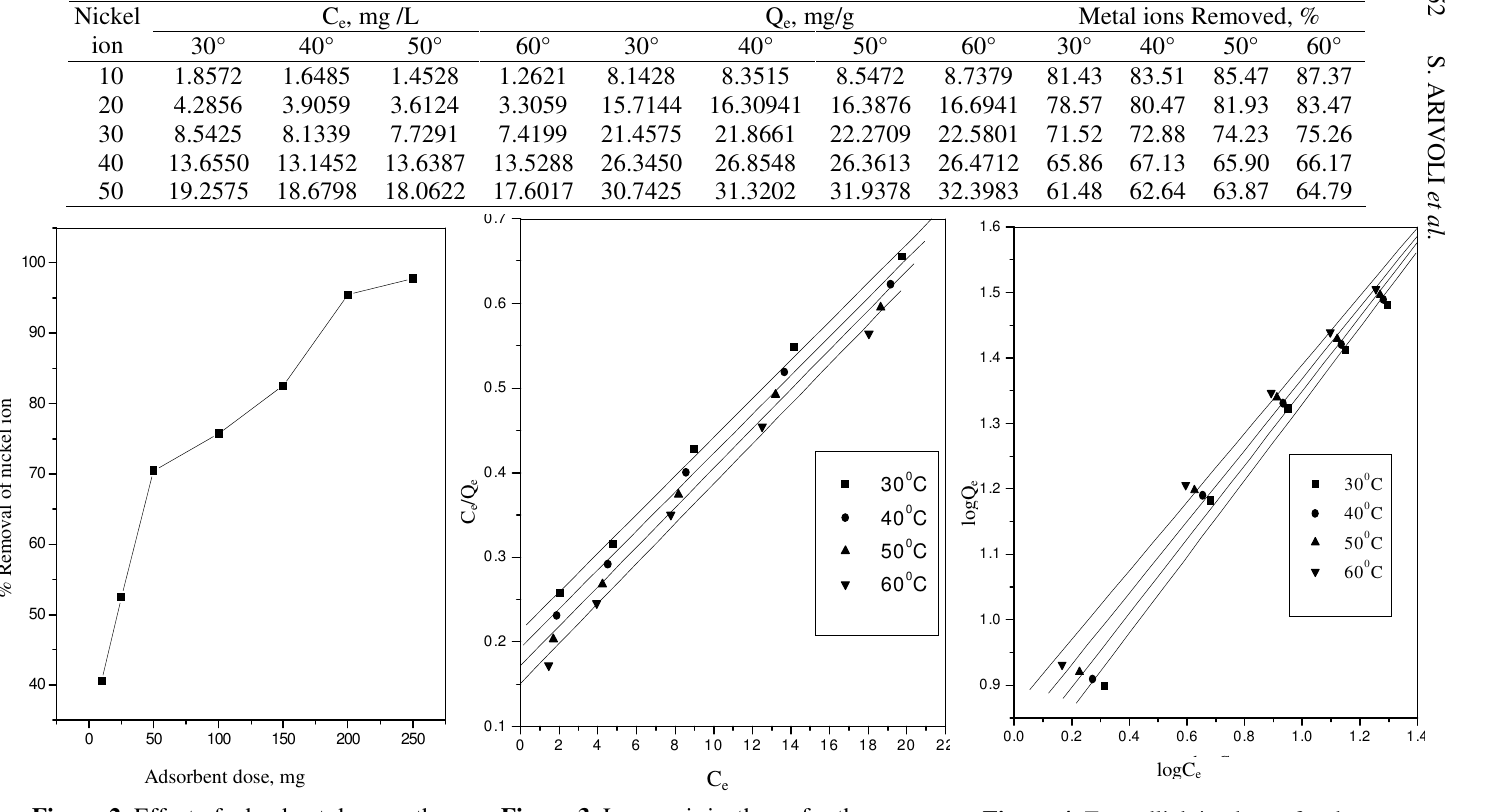
Figure 4 . Freundlich isotherm for the adsorption of nickel